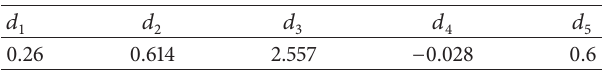
Table 3: Calibrated uncoupled damage model